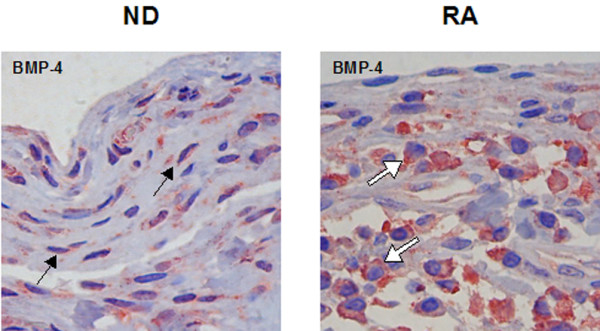
Expression of BMP-4 in fibroblastoid (black arrow) and macrophagocytic (white arrow) cells by immunohistochemistry. Original magnifications: normal donors (ND), rheumatoid arthritis (RA) ×100. BMP, bone morphogenetic protein.